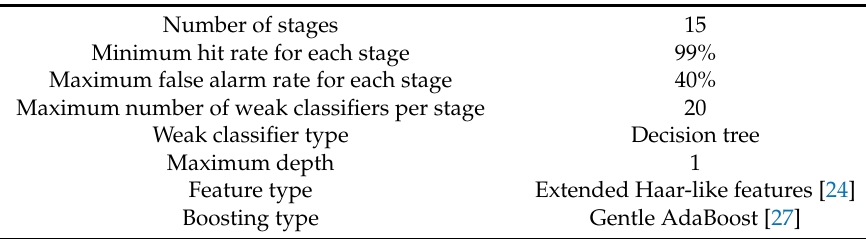
Table 1. Settings used for the storm drain classifier used in this study. Explanations for the settings can be found in the OpenCV user manual [26].